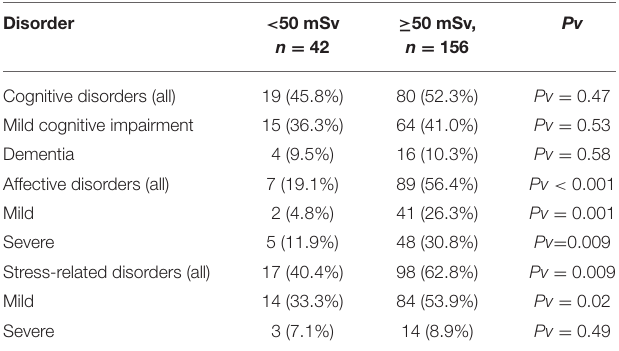
TABLE 4 | Assessment of cognitive, affective, and stress-related disorders in clean-up workers exposed to radiation in doses < 50 mSv (internal control) vs. those exposed to ≥ 50